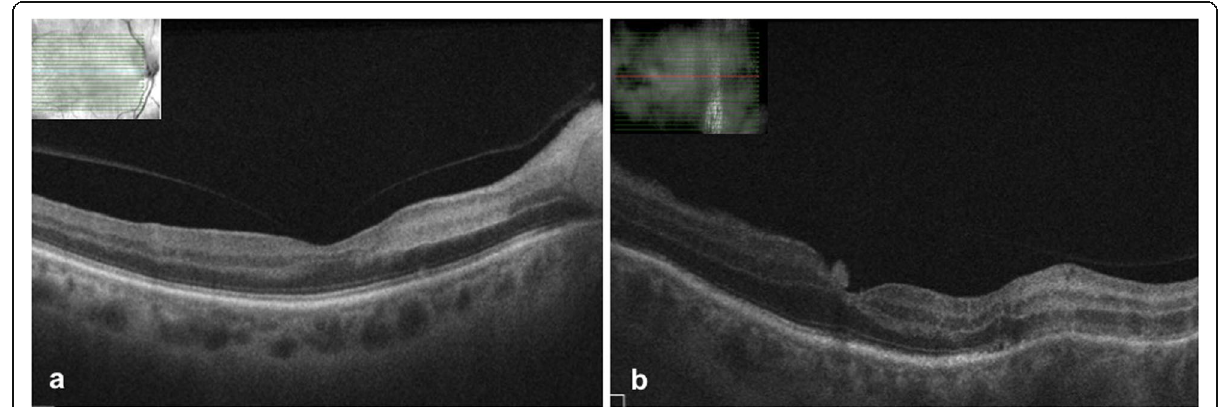
Fig. 2 a OCT scan of the right eye showing hyper-reflective band in the inner plexiform and inner nuclear layers. b OCT scan of the left eye showing thickening of the retinal